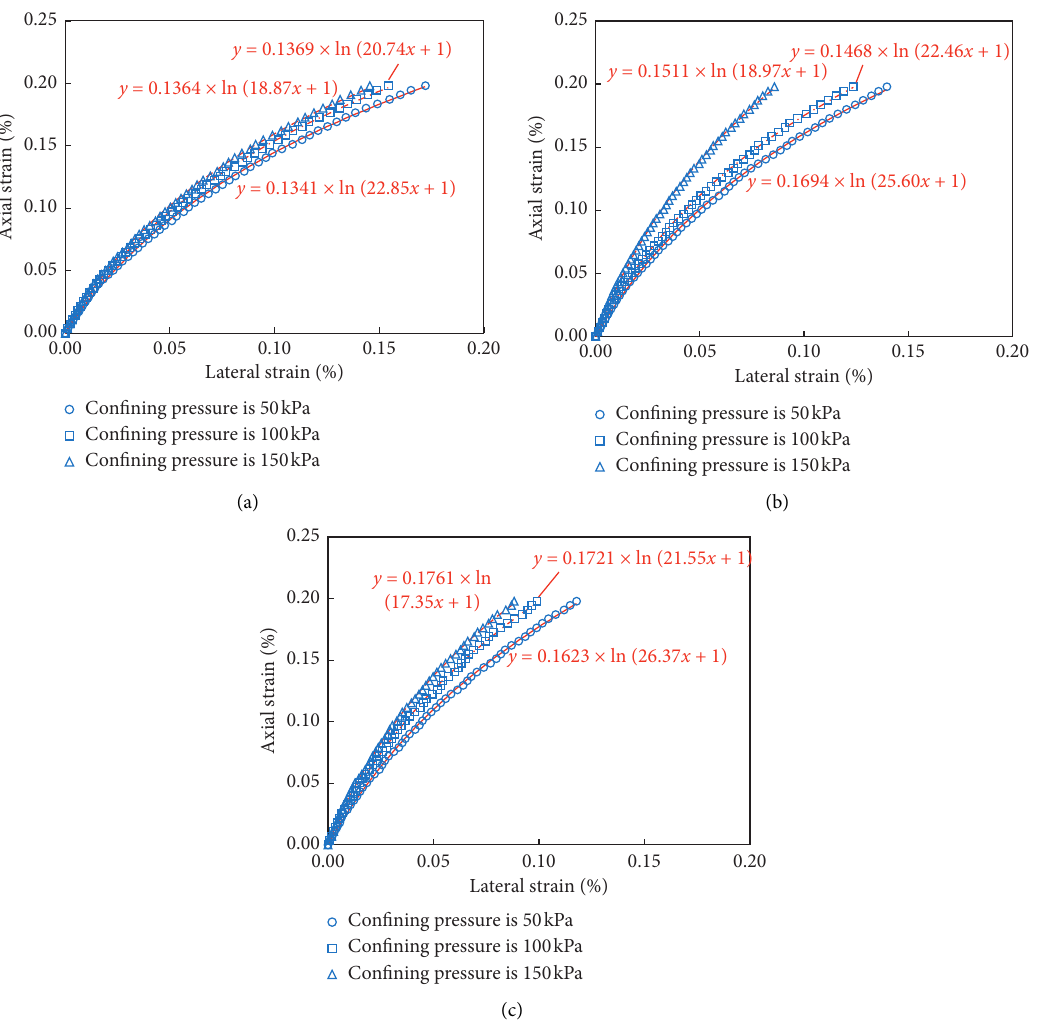
Figure 5: Relationship between axial strain and lateral strain: (a) degree of compaction is 90%; (b) degree of compaction is 93%; (c) degree of compaction is